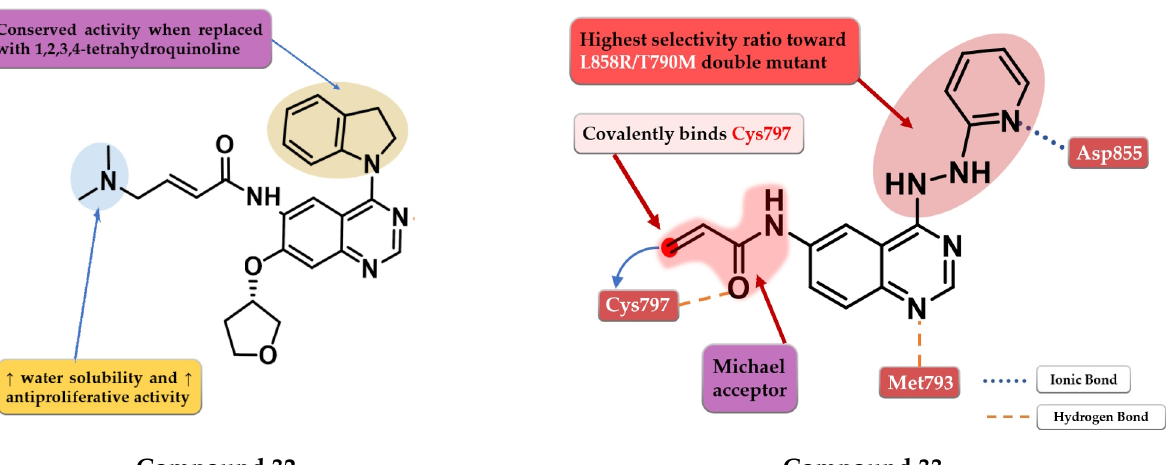
Figure 22. Structure–activity relationship and molecular docking of compound 32 covalently bonded in the active site of EGFR T790M , as reported by OuYang et al. [175]; structure–activity relationship and molecular docking of compound 33 covalently bonded in the human EGFR L858R/T790M kinase domain (PDB ID 3IKA) [177], as reported by Pawara et al. [176].